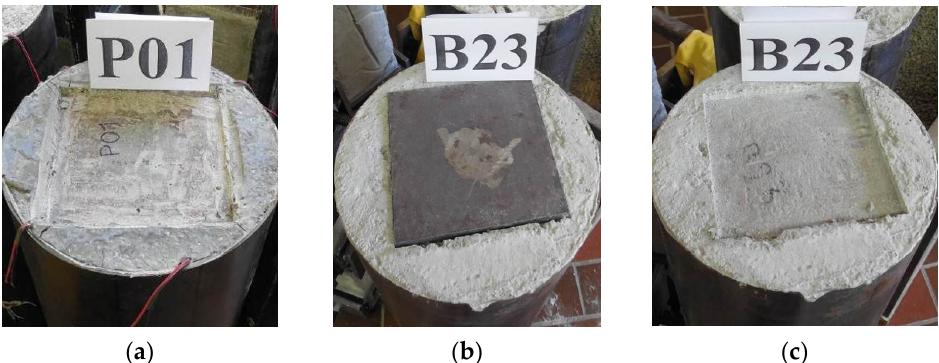
Figure 12. Failure modes of strengthened columns at the top end plane. Cracks in specimen P01 ( a ), embedded top bearing plate ( b ), and removed top bearing plate ( c ).